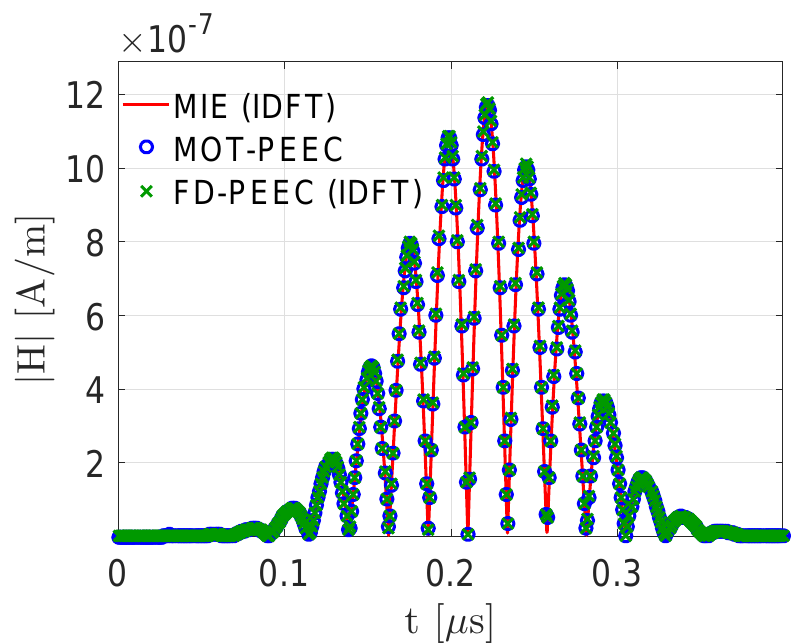
Figure 4. Scattered magnetic field norm for case 1.